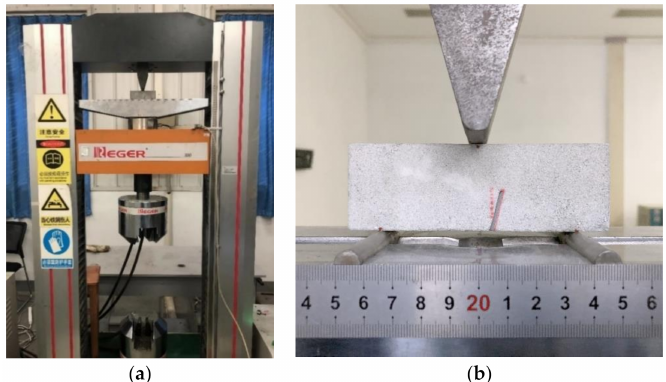
Figure 9. ( a ) The full view of experimental machine. ( b ) The loading